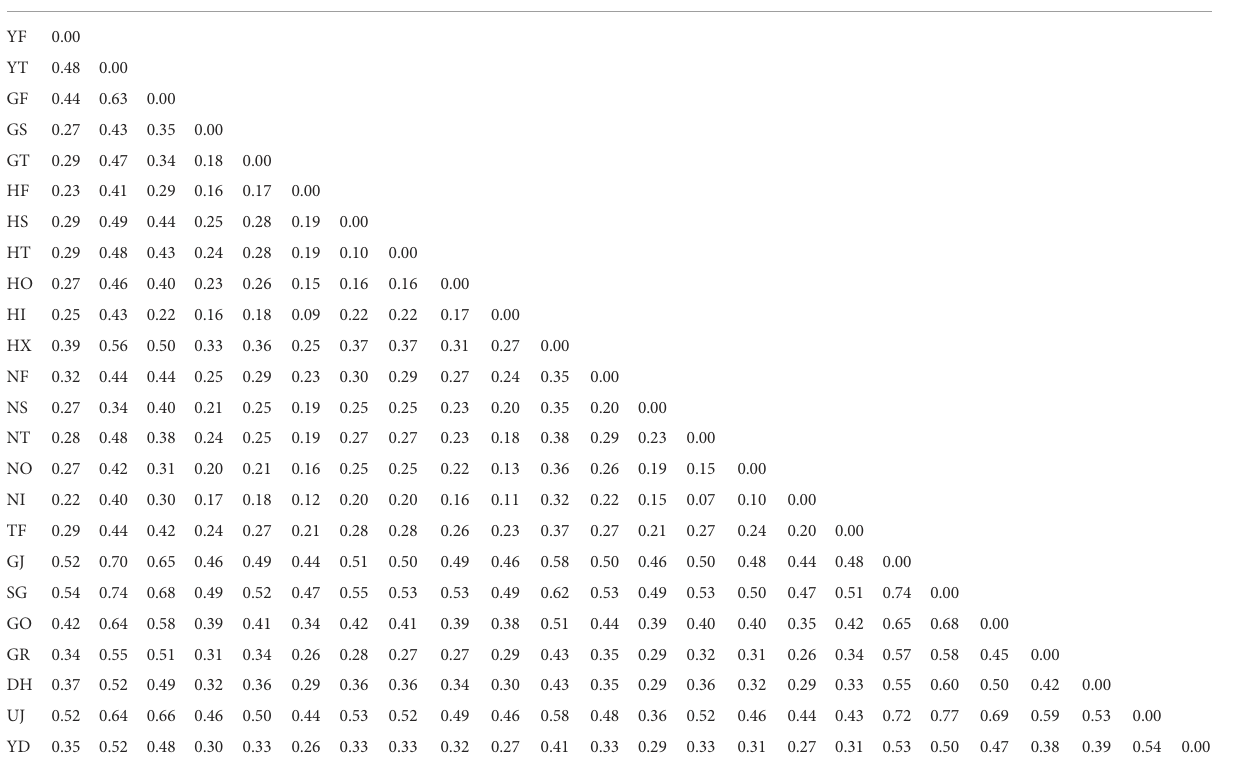
TABLE 2 Mean pairwise F ST values computed from 2,696 SNPs among 24 Sicyos angulatus populations in South